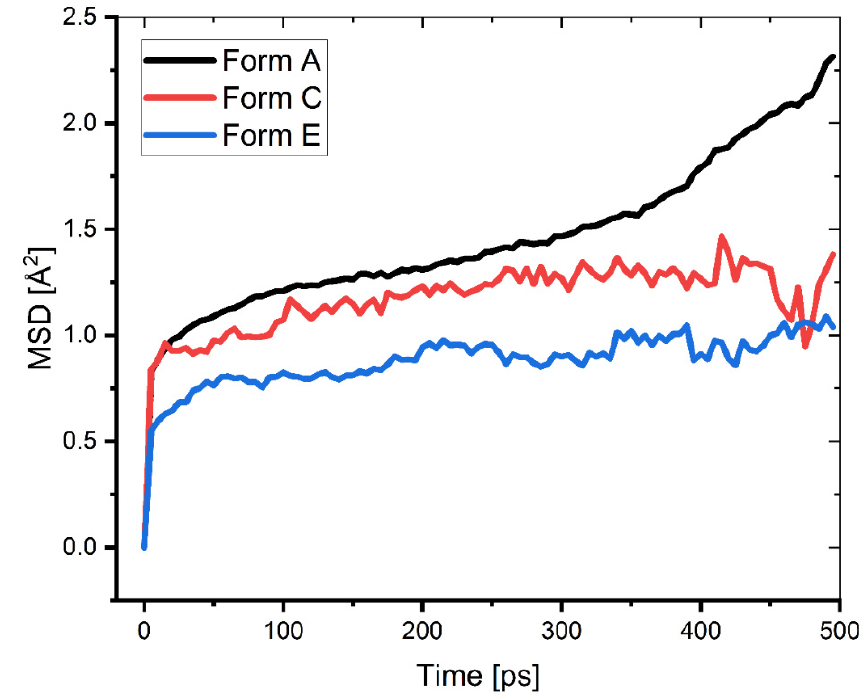
Figure 11. MSD of the different protonated forms of the Pantoprazole inhibitor during the second half of the MD simulation.